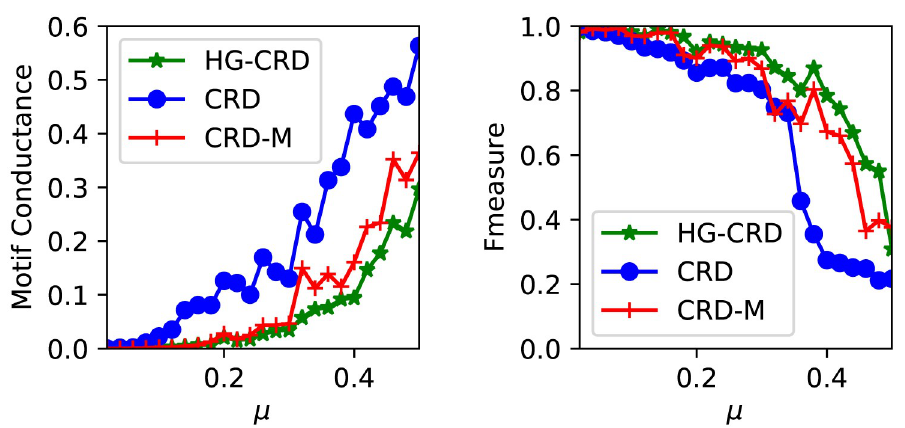
Fig 4. Comparison between CRD, CRD using motif adjacency matrix (CRD-M) and hypergraph CRD (HG-CRD) on LFR synthetic datasets. We don’t discuss some of the PageRank algorithms as those are outperformed by CRD as shown in previous experiments [30].